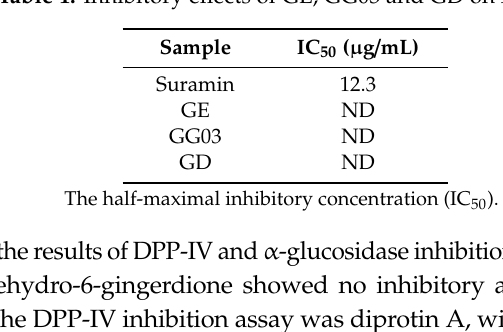
Table 1. Inhibitory e ff ects of GE, GG03 and GD on PTP1B.